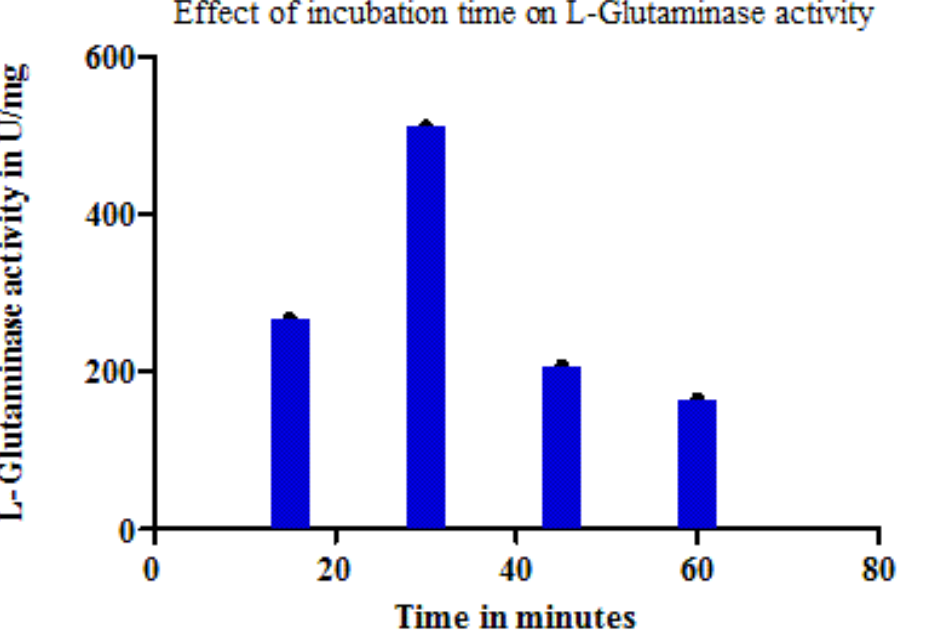
Figure 9. Purification of L-glutaminase produced by A. xylosoxidans RSHG1 by column chromatography using Sephadex G-75. The purified enzyme L-glutaminase produced by A. xylosoxidans RSHG1 was characterized for kinetic parameters. The maximum activity was recorded to be 511 U/mg at 37 °C, pH 7, after 30 min of incubation (Figure 10).